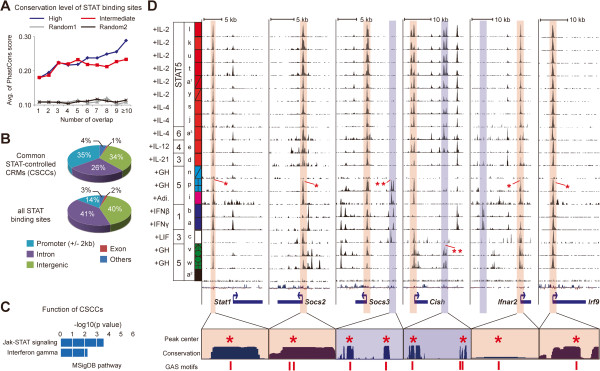
Characterization of common STAT binding sites. (A) Sequence conservation of shared STAT binding regions was calculated and averaged using PhastCons score. The x-axis indicates the number of overlaps by any of the STAT binding sites. Two random sets were generated (same number of regions – high / intermediate sets) for comparison. Pearson’s correlation coefficient r = 0.95 (high), r = 0.69 (intermediate), r = 0.04 (random1) and r = 0.53 (random2). (B) Distributions of STAT-associated CRMs and all STAT binding sites were estimated. The ‘others’ category includes 5′- and 3′-UTRs. (C) Statistically significant pathways associated with the genes near CRCCs were inferred using the GREAT tool with the following default settings; Basal plus extension – proximal: 5 kb upstream and 1kb downstream / distal: up to 1000 kb [28]. P-value is the Bonferroni corrected binomial P-value. (D) STATs 1, 3, 4, 5 and 6 can bind to the same sites in similar or different cell contexts. Six loci encoding Stat1, Socs2, Socs3, Cish, Ifnar2 and Irf9 are shown. Red vertical bars overlapping peaks indicate the binding regions of STATs 1, 3, 4, 5 and 6 shared between several cell types, while blue vertical bars represent the sites with unique context-dependent STAT binding. The bottom panel depicts positions of peak summits and sequence conservation as well as GAS motifs (TTCnnnGAA, perfect match) at the STAT binding regions. The total number of tags in ChIPed samples was normalized to the corresponding input using the wignorm program [24] and the y-axis scale was adjusted according to this normalized value using auto-scale function of the UCSC genome browser. Red asterisks denote peak centers.